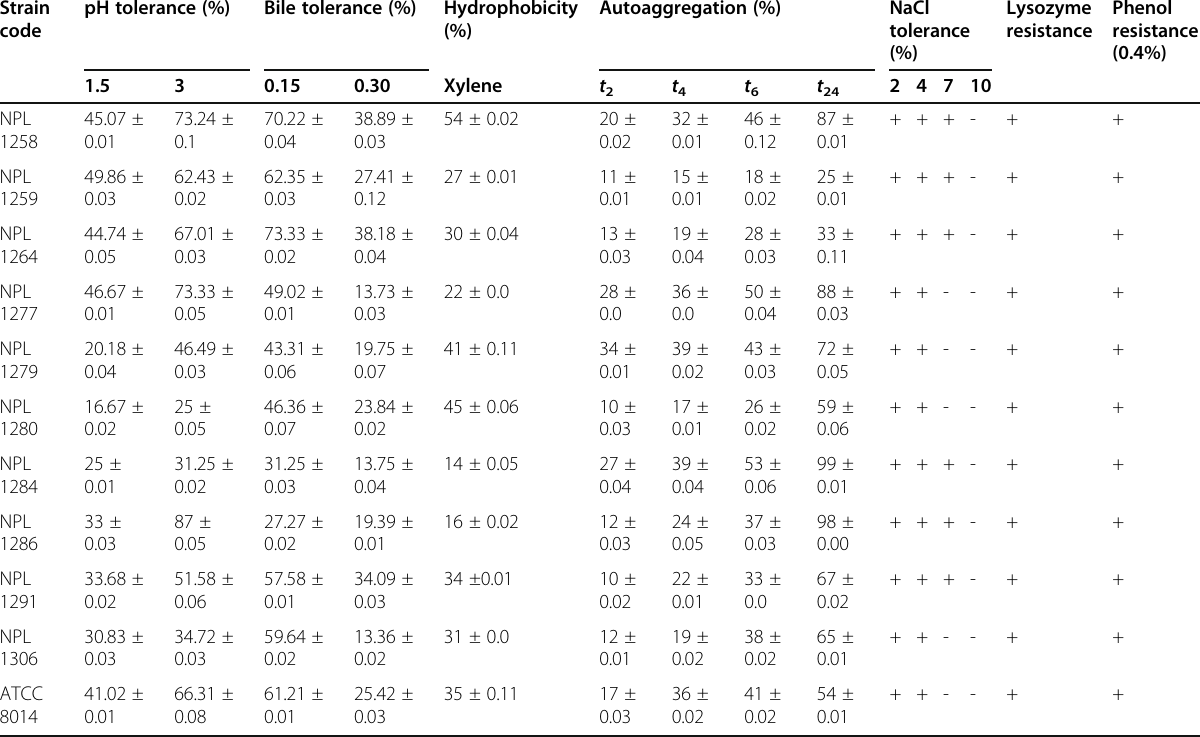
Table 3 Probiotic potential characteristics of the selected LAB strains Strain